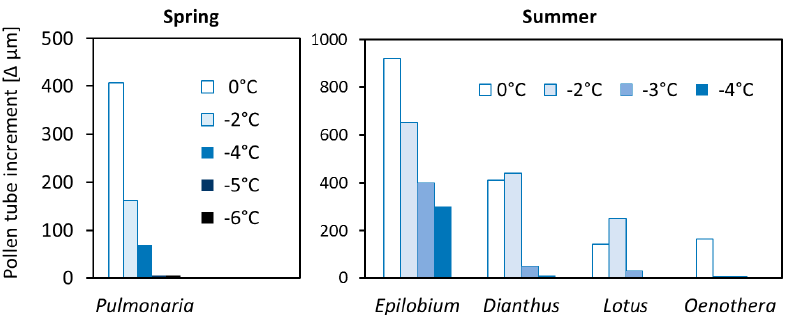
Figure 7. Frost after-effects on pollen tube growth in the spring flowering species Pulmonaria and in four summer-flowering species. Bars show the difference between the mean pollen tube lengths at the end of the 24 h recovery phase (S3) and the end of the cooling down phase (S1) in the step cooling experiment with different target temperatures.